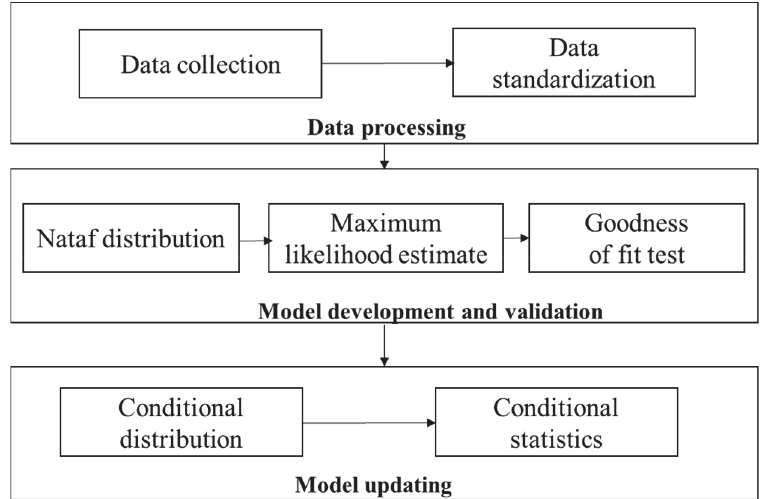
Figure 2. Methodology